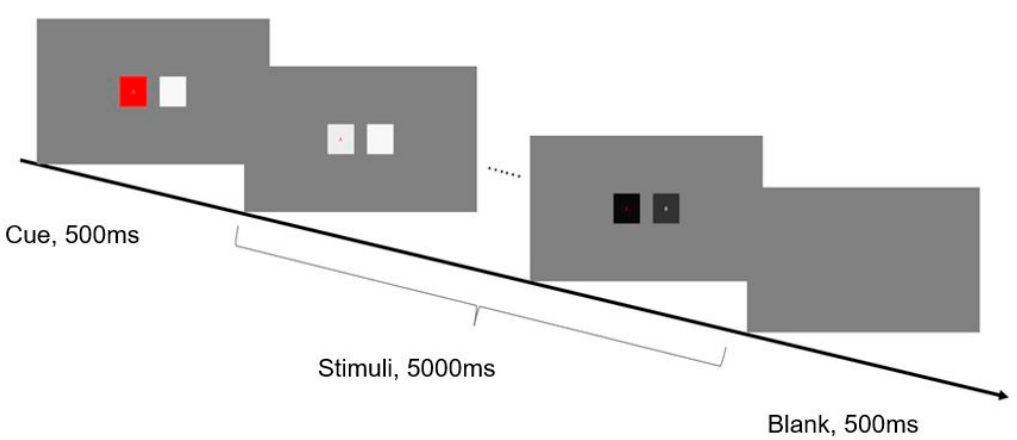
Figure 1. An example sequence of displays in a typical trial of Experiment 1. The experimental stimuli were two squares presented in the center of the screen. Each trial started with a 500 ms cue phase. In this stage, the two squares were at rest, one of which was red (target) and the other was white. Then, the luminance values of two squares were respectively modulated by sinusoidal coding at different frequencies, e.g., alternated from black and white, and they flashed for 5 s. Between trials, an empty screen was presented for 500 ms. Participants were required to pay attention to the red square, where the center letter was the object of fixation.